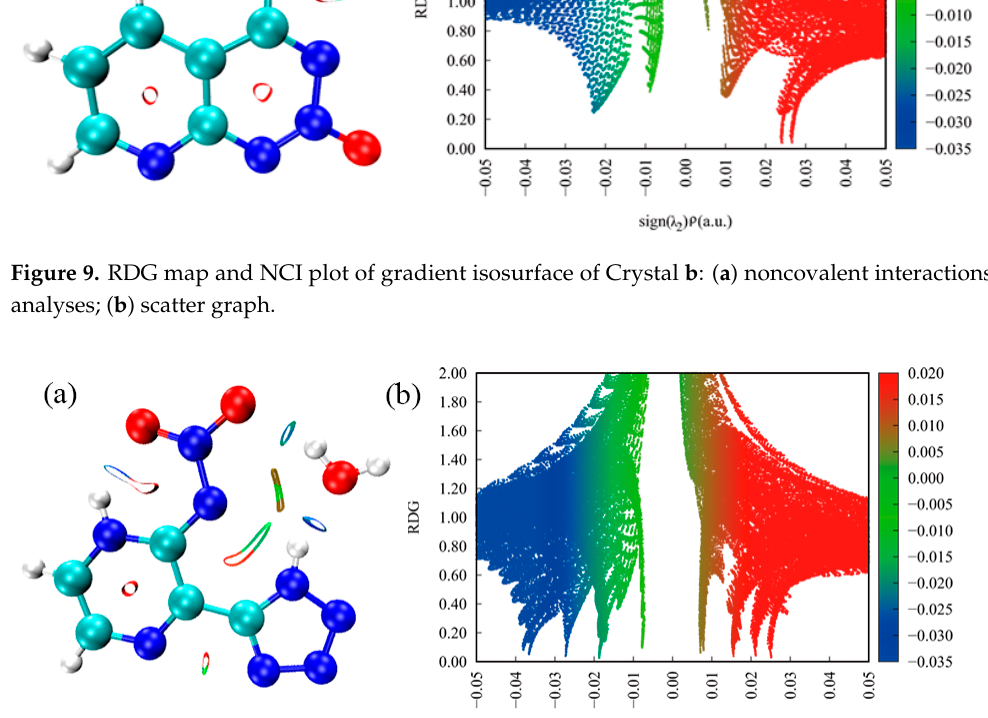
Figure 10. RDG map and NCI plot of gradient isosurface of Crystal c : ( a ) noncovalent interactions analyses; ( b ) scatter graph.